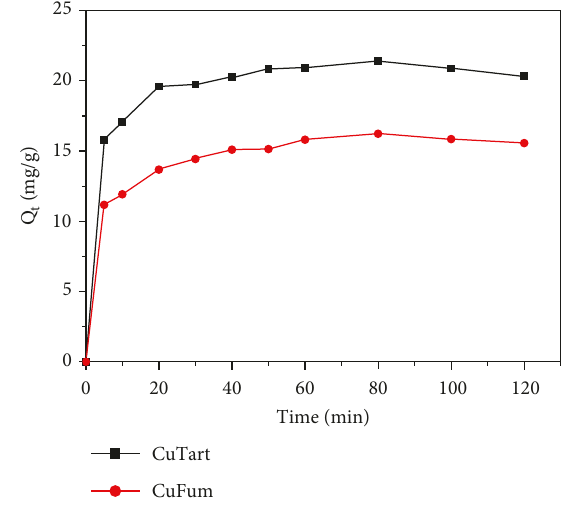
Figure 5: Effect of contact time on the adsorption of phenacetin onto CuTart and